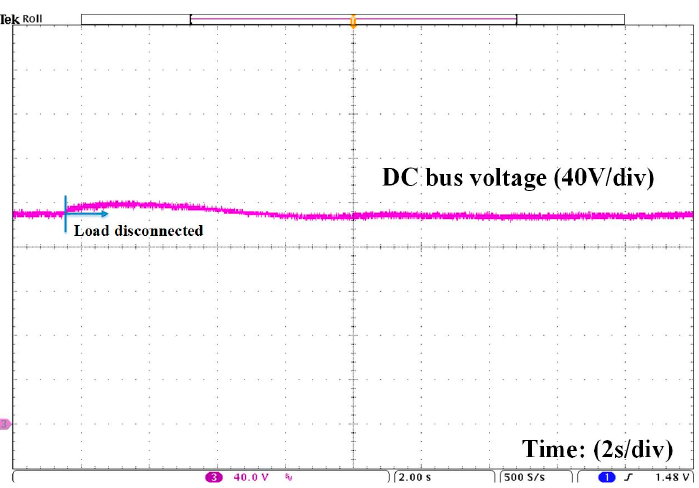
Figure 28. Disconnection of 300 W fluorescent lamps.